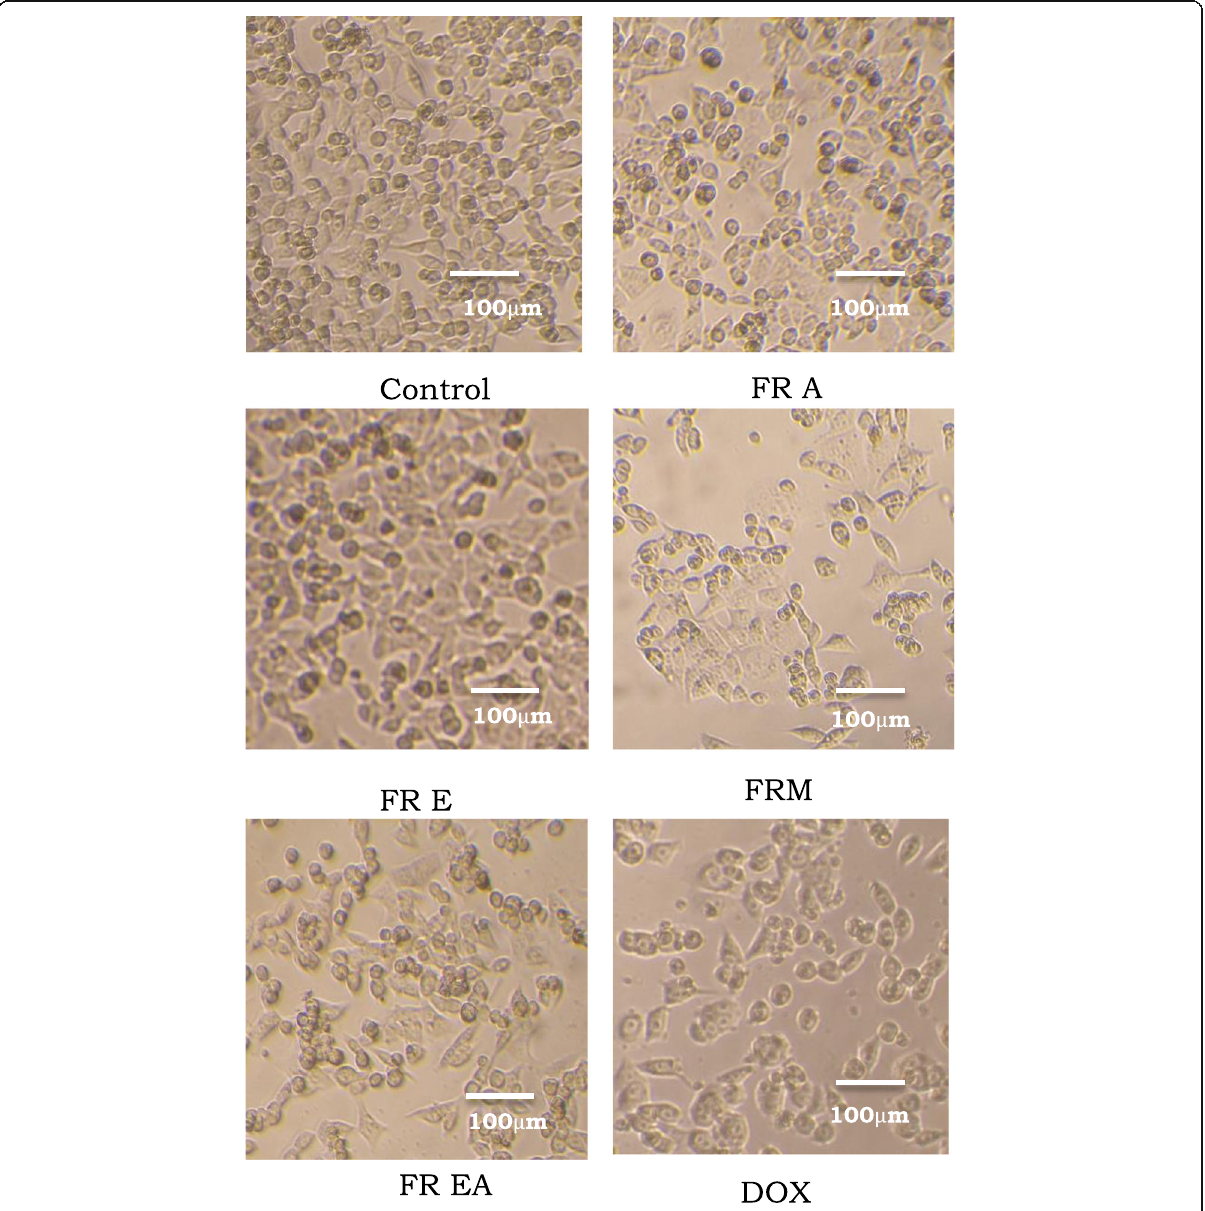
Fig. 3 Morphological changes observed in HCT 116 cell line when treated with IC 50 concentrations of F. religiosa latex solvent extracts along with control (HCT 116) and doxorubicin (DOX)-treated cells. A — acetone (120.71 μ g/ml); E — ethanol (24.27 μ g/ml); M — methanol (122.89 μ g/ml); EA — ethyl acetate (101.56 μ